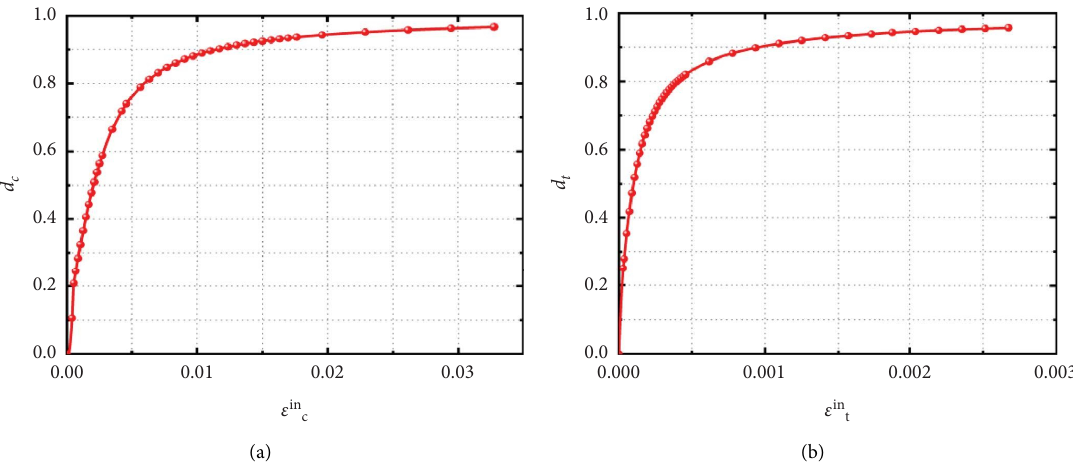
Figure 23: Compressive and tensile damage behaviors of